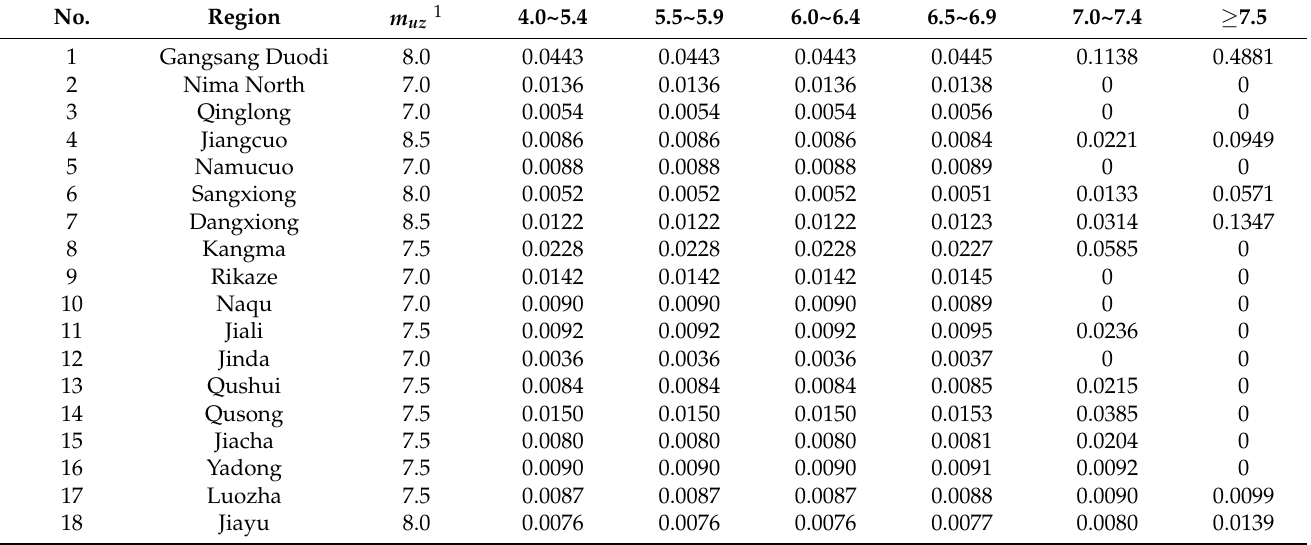
Table 3. Spatial distribution functions of the main potential source